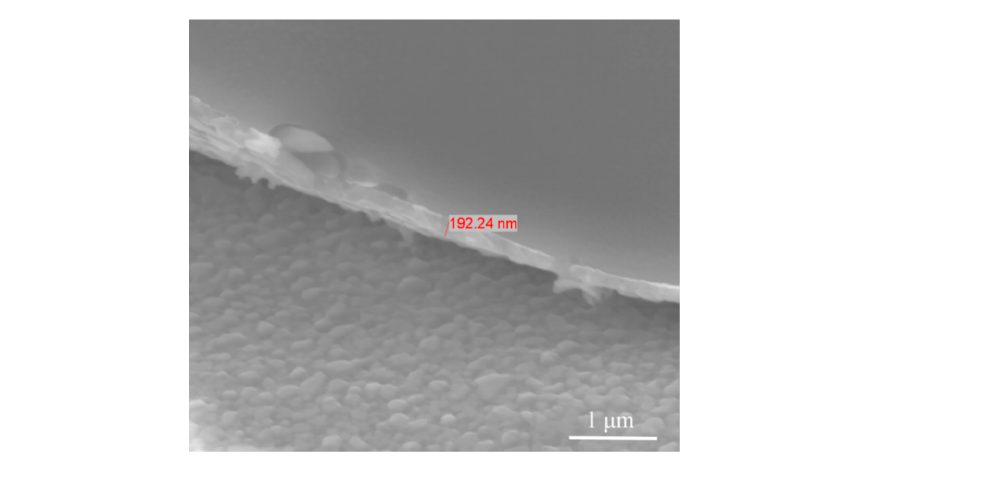
Figure 12. ( a ) The micro-morphology of 5083 alloy scraps after being held in Al-4.5Mg alloy melt for 15 min; ( b ) Corresponding EDS results.